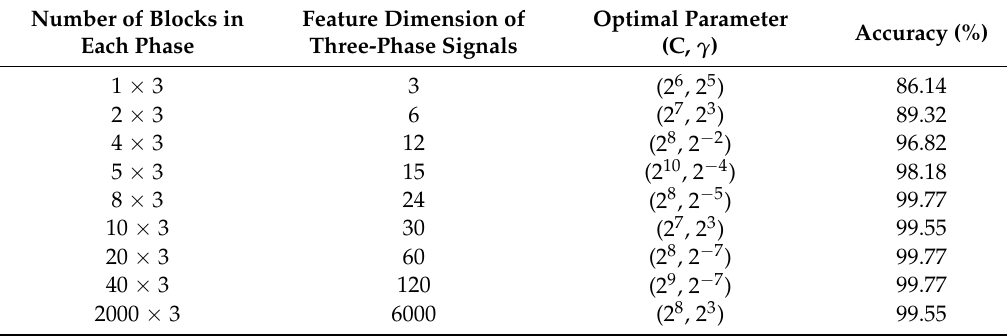
Table 4. Parameter effection on classifier